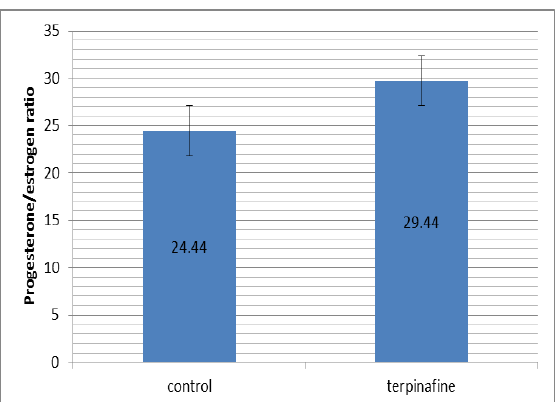
Figure 2: The effect of terbinafine treatment on progesterone/estrogen ratio in control and terbinafine treated groups.